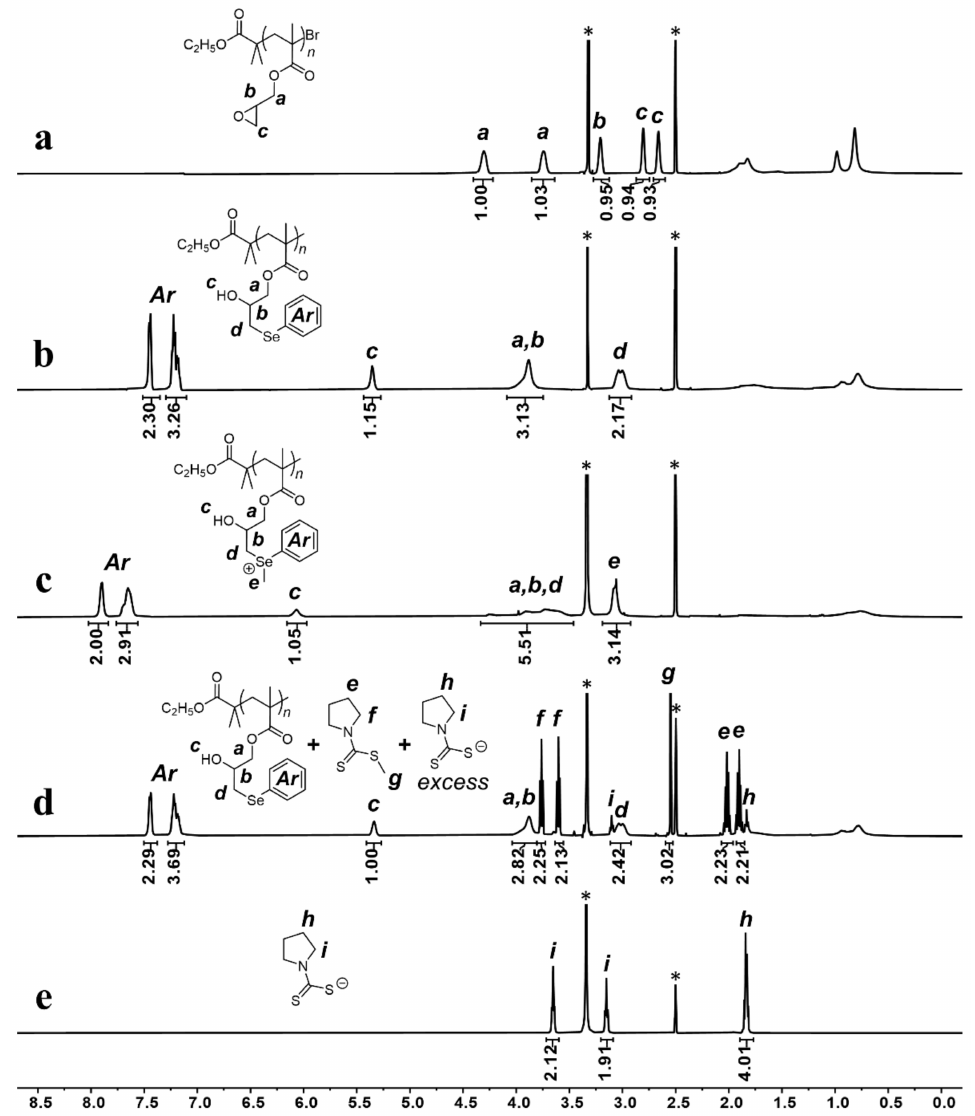
Figure 2. The 1 H-NMR of PGMA ( a ), polymer 1 ( b ), and polymer 2 before ( c ) and after addition of a slight excess of APDC (1.1 equiv./cation) ( d ). The measurement was carried out immediately after the addition of APDC to the polymer solution. The bottom shows the 1 H-NMR of APDC ( e ). Signals from residual solvents (water and dimethylsulfoxide) are shown with an